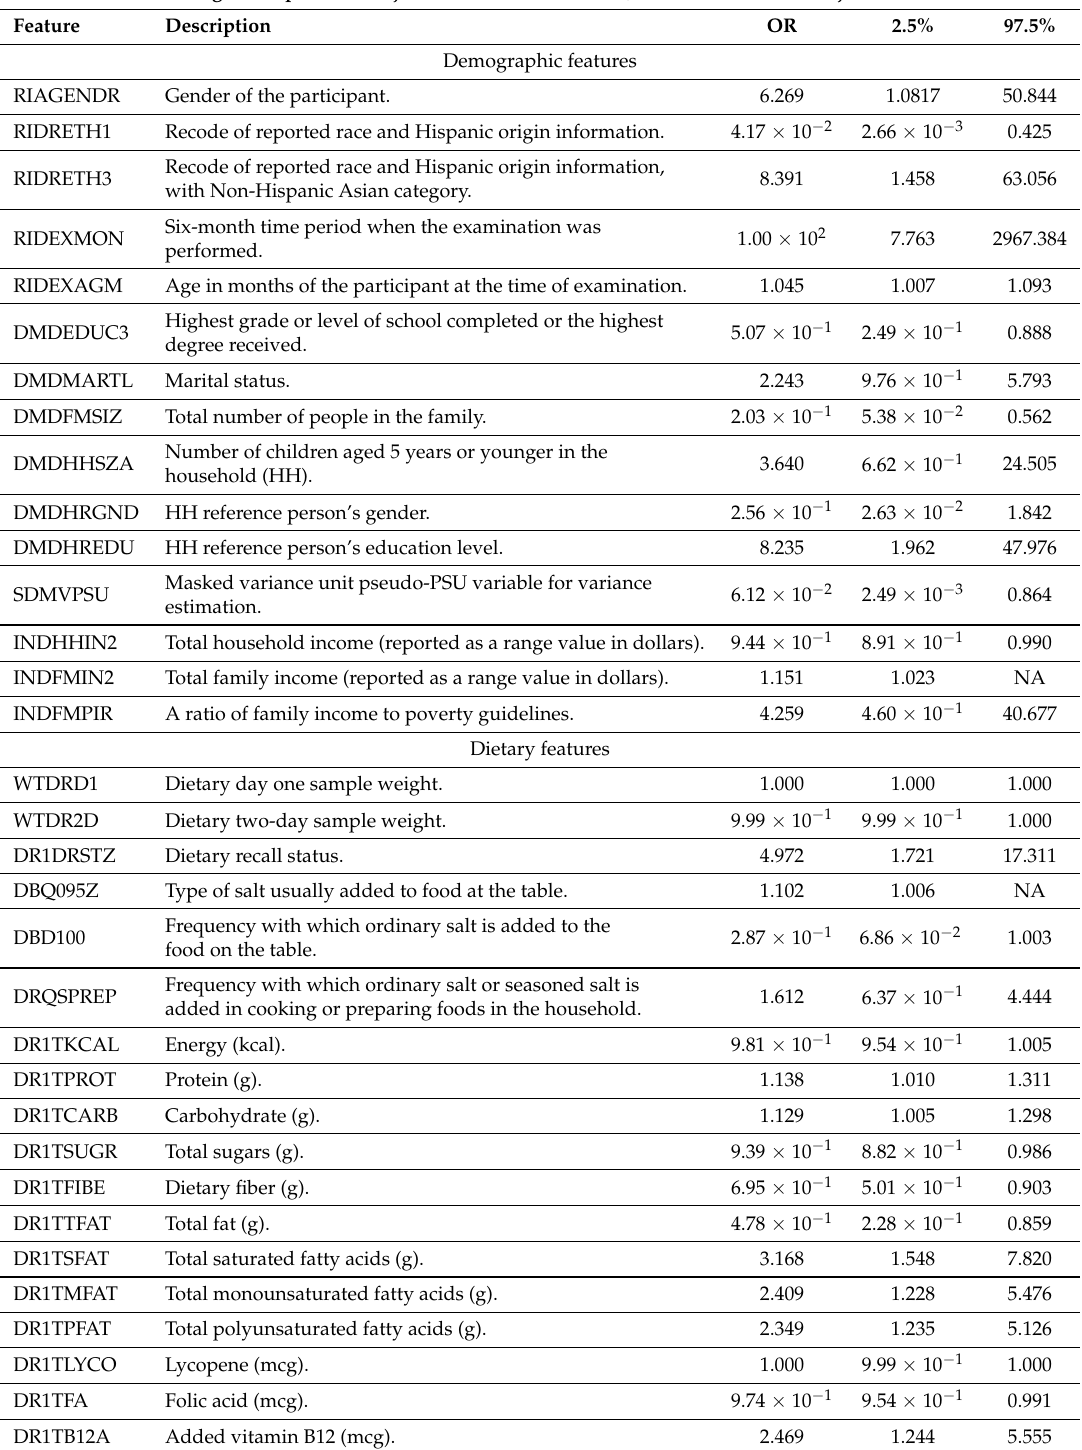
Table 2. Odds ratio (OR) values and confidence intervals (2.5%/97.5%) obtained by the statistical analysis of the multivariate model corresponding to age group 2, containing 15 demographic features and 18 dietary features. PSU: primary sampling